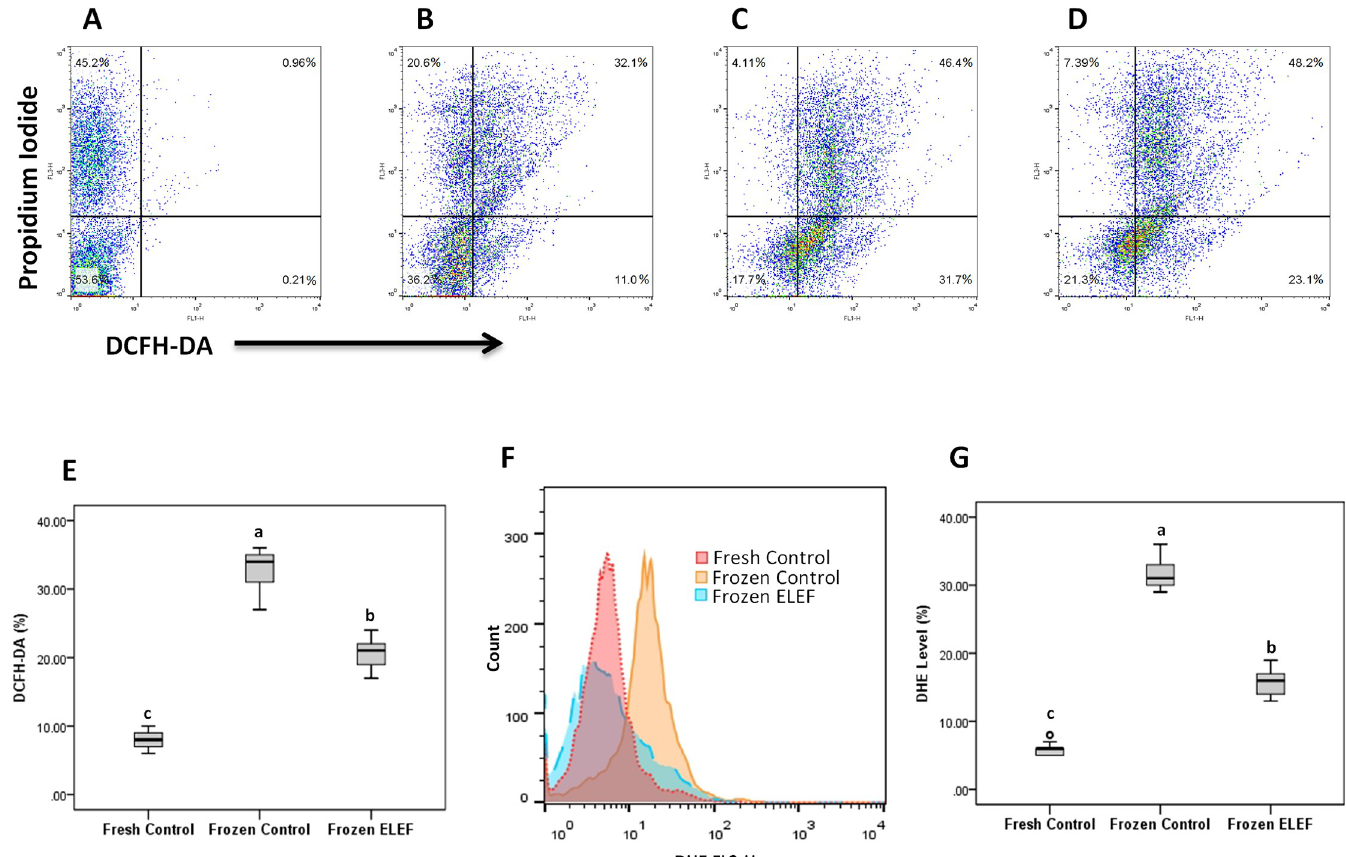
Fig 5. ROS in three group specimens were analyzed using flow cytometry by staining with PI/ DCFH-DA-FITC and DHE. Flow cytometry of specimens stained with PI/ DCFH-DA (A-E) and DHE (F and G). Panel A represents PI control without DCFH-DA, panels B-E represent ROS production in the live or dead sperm population. Panel F and G represent DHE levels in fresh and frozen controls and frozen ELEF. The assigned letters of a, b and c indicate significant differences (p < 0.05) among the groups. Values are expressed as mean ± SD.